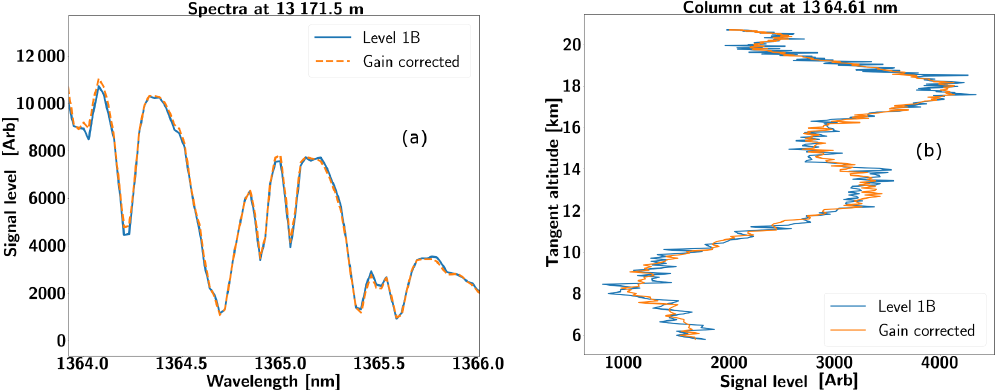
Figure 16. Correction of the L1B spectra. Variability before and after the secondary correction is applied for an example row spectrum at a fixed altitude (a) and for a single wavelength column vs. altitude (b) .